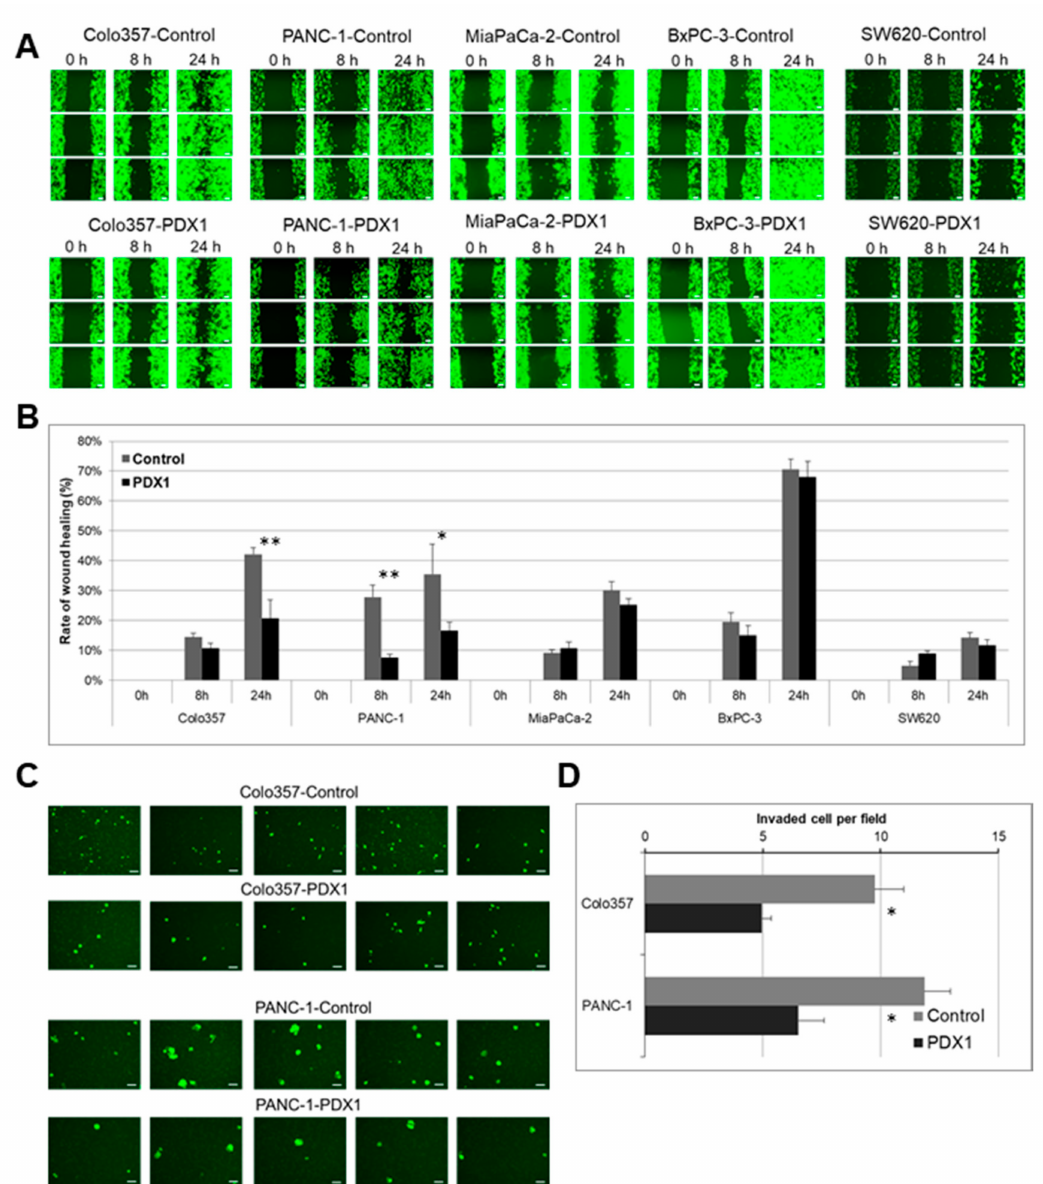
Figure 1. Effect of PDX1 on cell migration and invasion. Colo357, PANC-1, MiaPaCa-2, BxPC-3, and SW620 cell migration ( A , B ) analysis and Colo357, PANC-1 cell invasion analysis ( C , D ) were performed, as described in “Materials and Methods.” Representative pictures of three independent studies are shown. Magnification × 175. The white stripe corresponds to a scale of 100 µ m. Data are presented as the mean ± SD. * p < 0.05, ** p < 0.01 compared with control group, Manna–Whitney